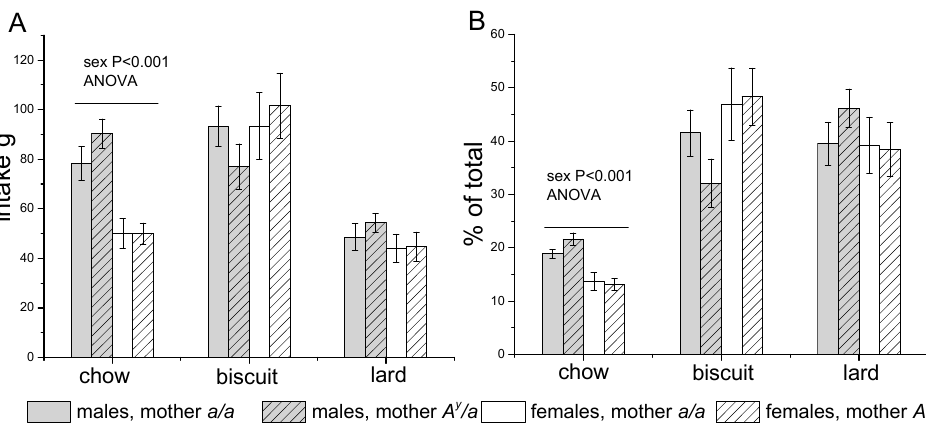
Figure 3. Total amount of food (g, ( A )) and share of energy (% of total, ( B )) consumed with different diet components by males and females born to a/a and A y /a mothers during 10 weeks of diet con- sumption. Data are presented as mean ± SE for 6–8 mice in each group. Data were analyzed by two-way ANOVA with factors “sex” and “MG” for each component of diet.